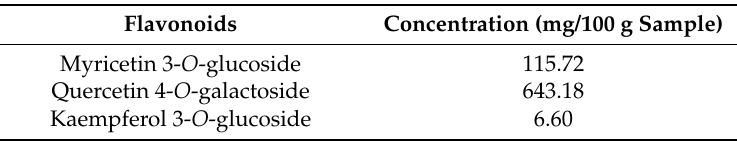
Table 3. Flavonoid content in raw black bean “Negro San